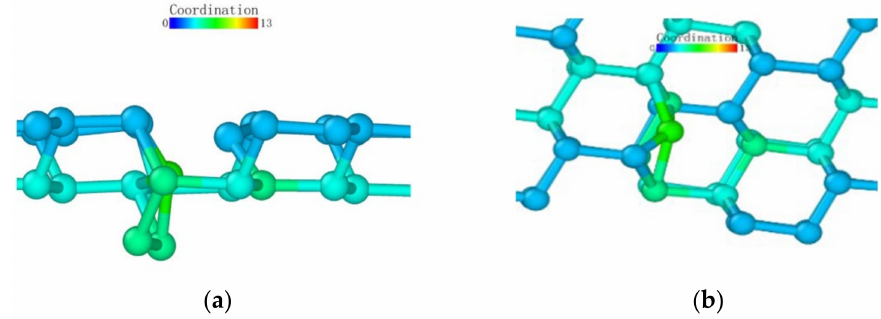
Figure 19. Atomic transient state at 0.16 nm stroke. ( a ) side view, ( b ) vertical view.